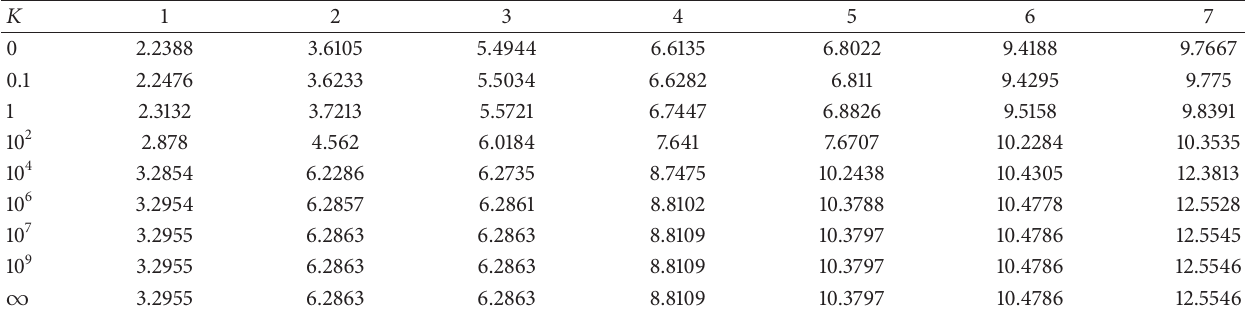
Table 8: The first seven frequency parameters Ω = ( 𝜔𝑏 2 / 𝜋 2 )( 𝜌ℎ/𝐷 ) 1/2 for C-C-F-C Mindlin rectangular plates with translational,